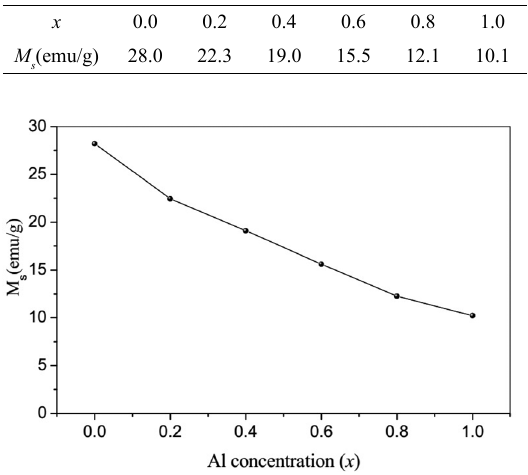
Figure 5. The saturation magnetization as a function of concentration for Y Al Fe O garnet 3 x (5- x ) 12